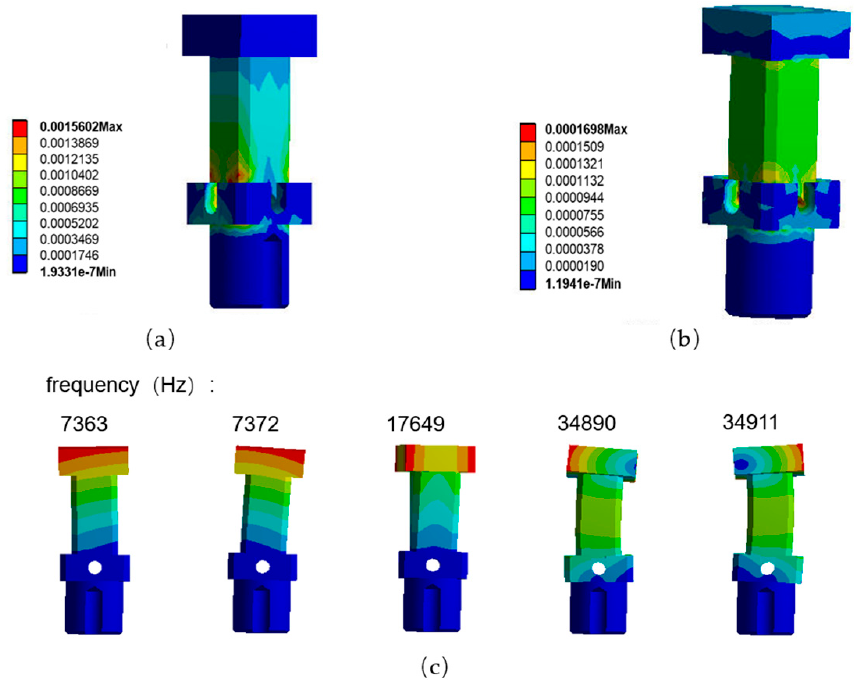
Figure 3. Finite element analysis results of the elastomer: ( a ) equivalent elastic strain in X/Y direction; ( b ) equivalent elastic strain in Z direction; ( c ) modal analysis of orders 1 to 5. A vertical downward force F Z of 740 N was applied in the Z direction at the center of the top surface, and the strains were found to be highest at the four vertices in the middle of the transducer; therefore, the transducer was most sensitive in this area. As shown